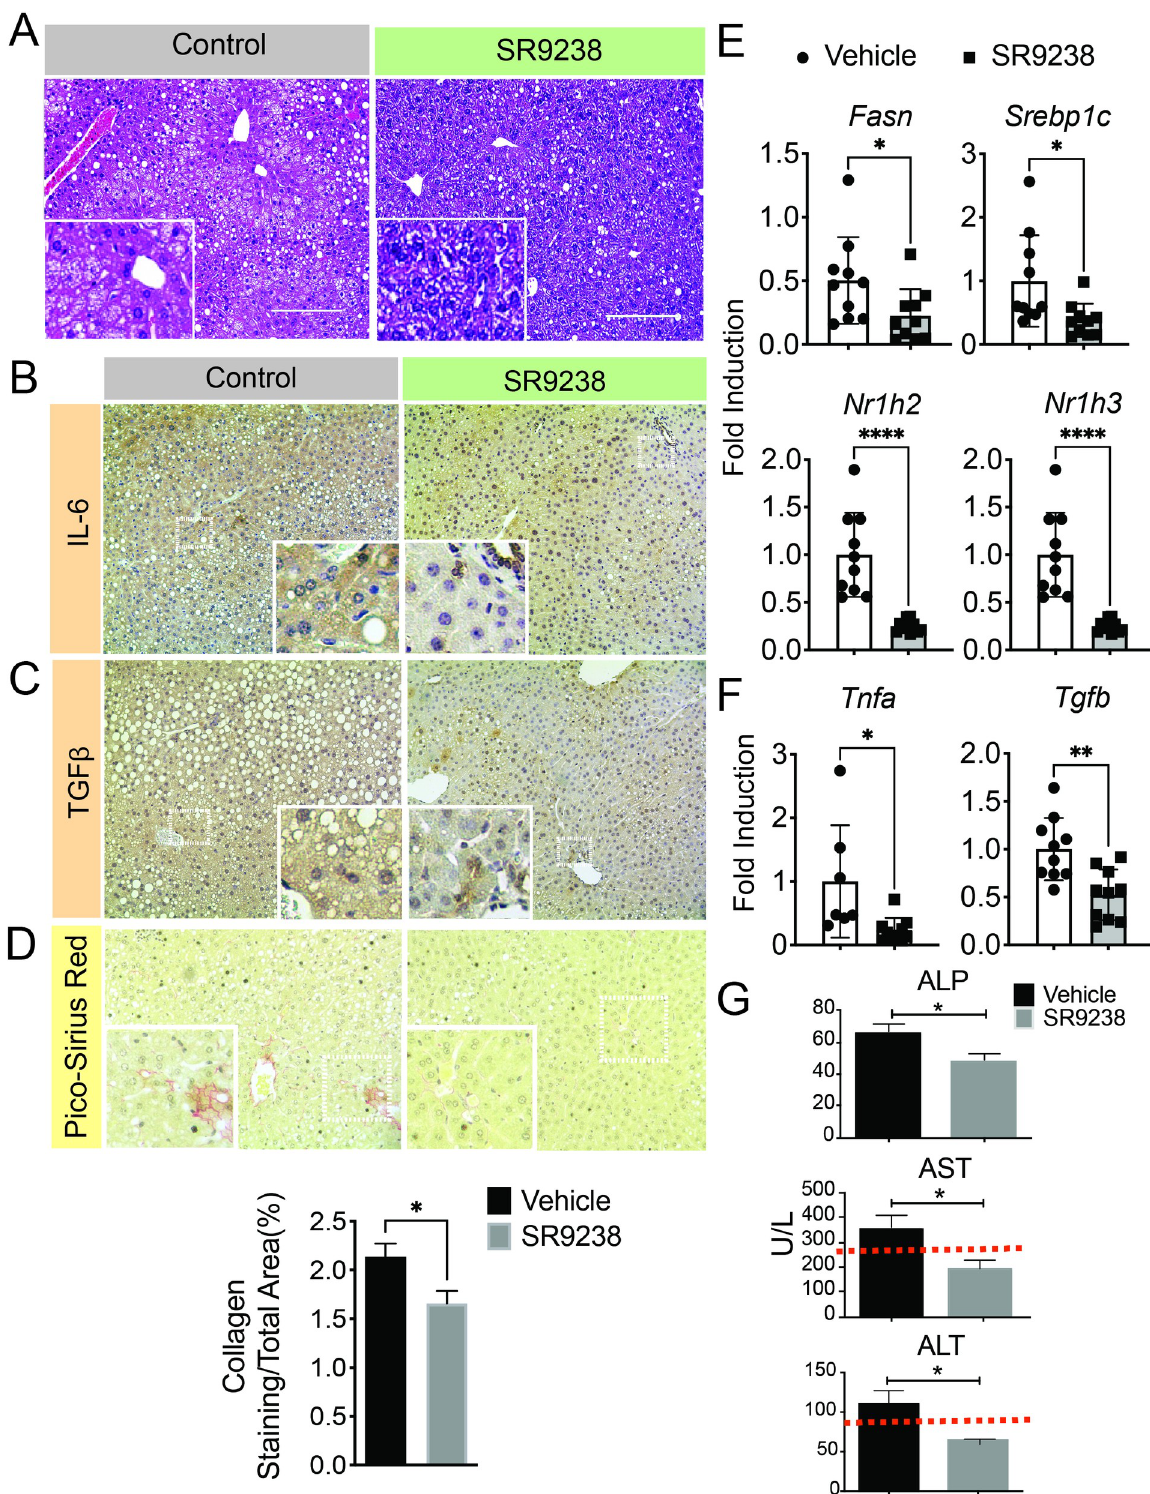
Fig 6. The WASH-ethanol diet model can be used to evaluate the effect of novel drugs on liver, toxicity, pathology and fibrogenesis. A. H&E staining of liver sections of mice (n = 10) placed on the WASH-ethanol diet and dosed with 30mg/kg SR9238 or vehicle control (10:10:80 DMSO:Tween80:PBS) Representative images (n = 10). Mice were placed on the WASH diet +/- ethanol for 2 weeks before dosing began. SR9238